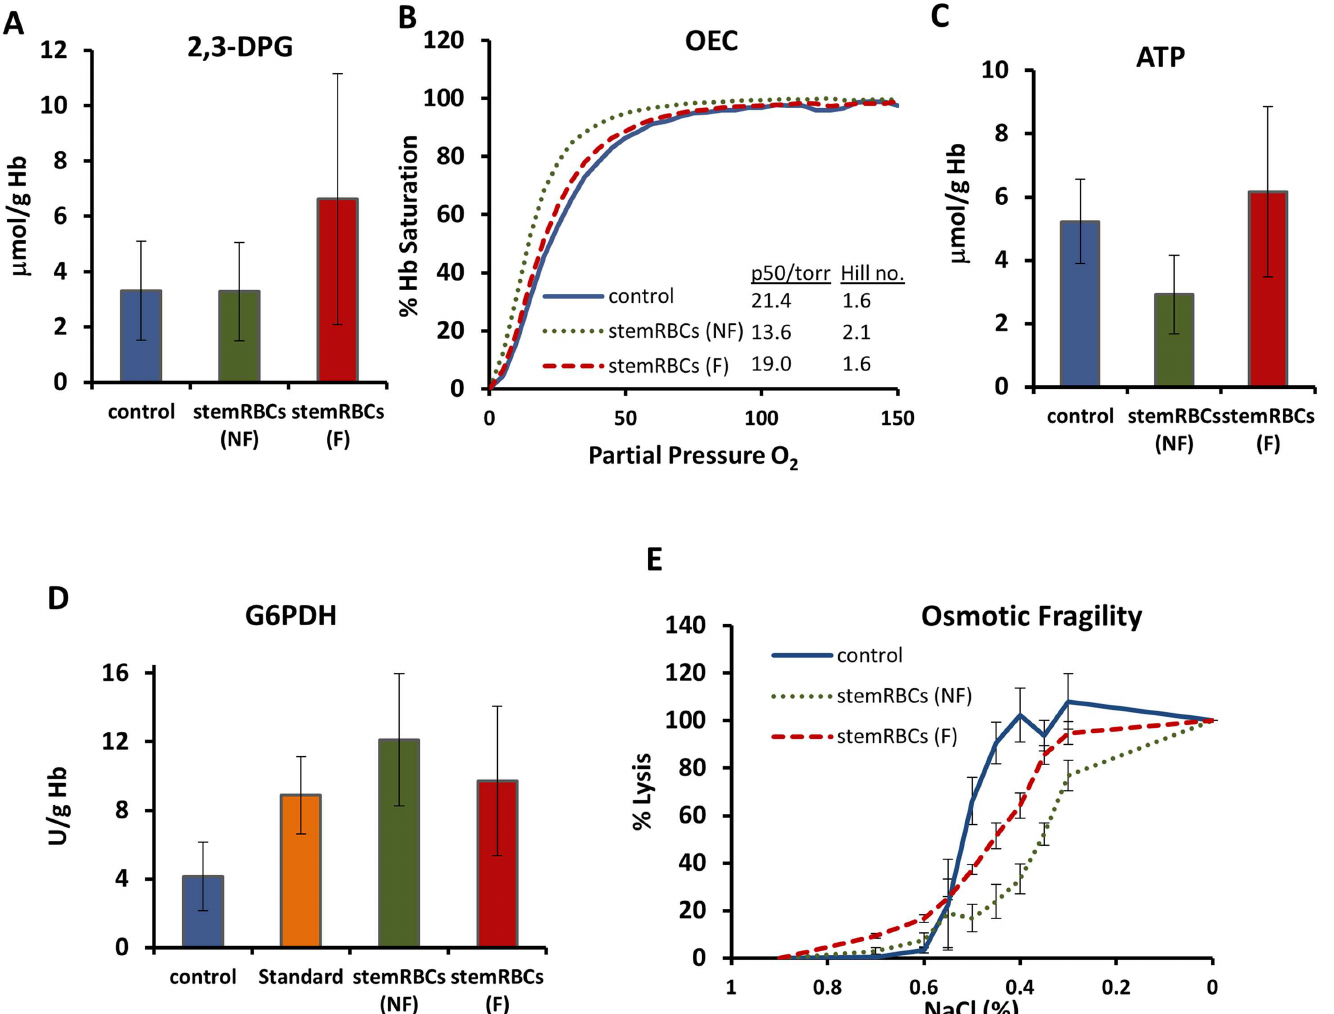
Fig 3. Analysis of biochemical and membraneproperty parameters. (A) 2,3-DPG levels in human control RBCs, as well as non-filtered (NF) and filtered (F) stemRBCs harvestedon day 18 of culture (n = 3)(mean ± SD). (B) Oxygen bindingcurves showingfiltered (F) and non-filtered (NF) stemRBCs harvestedon day 18 of culture and control RBCs (n = 3 each) (mean ± SD). (C) ATP and (D) G6PDH analysisof day 18 non-filteredand filtered stemRBCs (n = 3–5) as well as control and G6PDH standard(n = 8) (mean ± SD). (E) Osmotic fragility of filtered and nonfilteredstemRBCs harvestedon day 18 was assessedby exposingthem to decreasing amounts of saline and determining the amount of releasedhemoglobin by colorimetric assay (control RBCs were assessed simultaneously for comparison). Error bars show standard deviation.